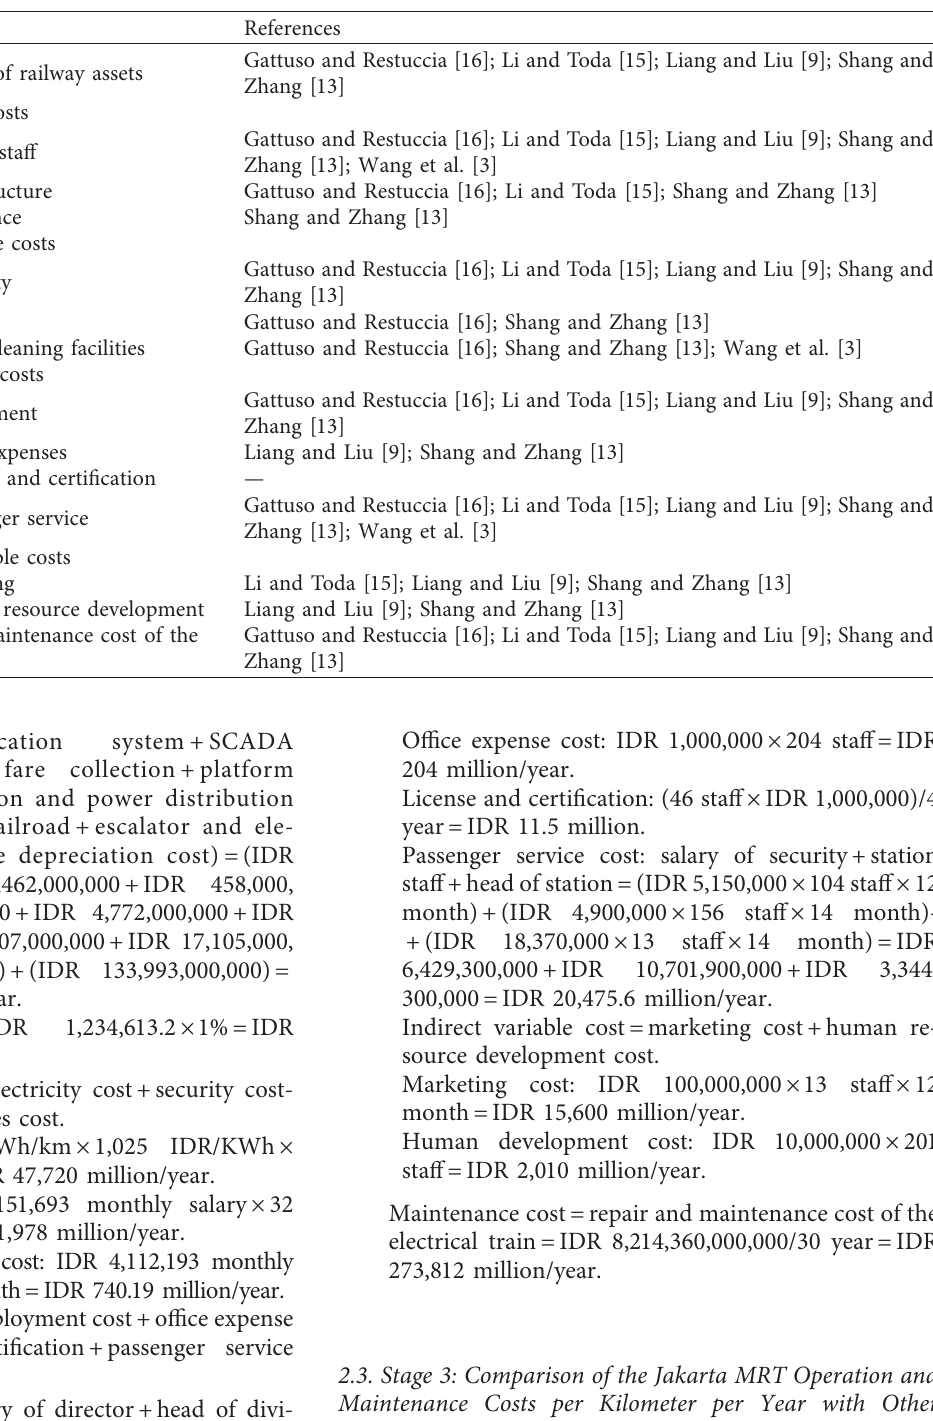
Table 2: MRT operation and maintenance cost groups and their